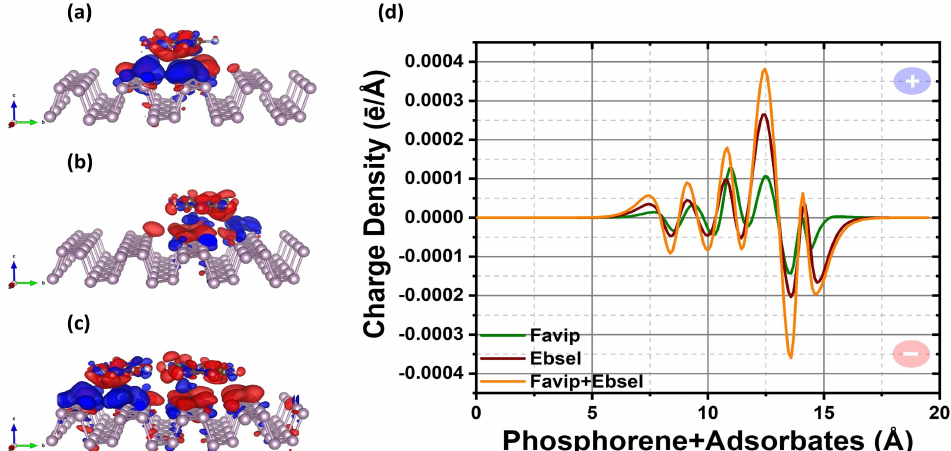
Figure 3. ( a – c ) Three dimensional (3D)–view of the electronic charge density difference δρ for favipi- ravir, ebselen, and hybrid molecules on phosphorene sheet ( δρ = ±3.5 × 10 − 4 ¯e/Å 3 ). The red and blue colors indicate isosurface electron accumulation and depletion, respectively. ( d ) Corresponding 1–D averaged electron–density difference ( δρ ( z )) along the adsorption direction for favipiravir (green line), ebselen (wine line), and hybrid (orange line) favipiravir+ebselen molecules on phosphorene